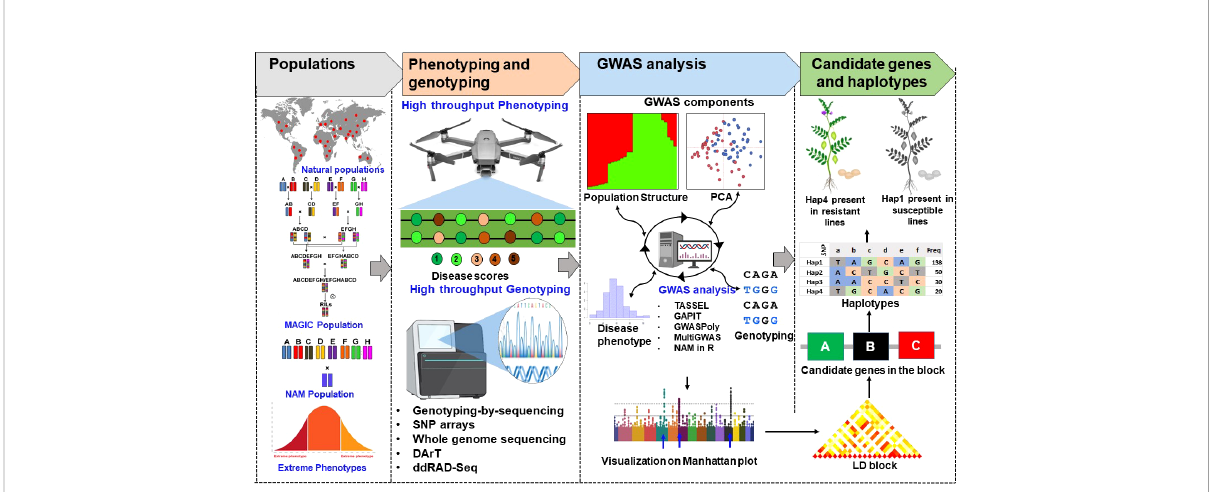
FIGURE 3 Illustration of genome-wide associations studies to identify genes associated with disease resistance. The partially structured (NAM and MAGIC) and unstructured populations (germplasm lines, association panels) can be used for high throughput phenotyping and genotyping to perform high resolution association mapping with advance tools for genome wide association analysis (GWAS). The peaks identi fi ed in GWAS analysis can be used for identi fi cation of LD blocks. Each LD block includes one or few candidate genes associated with the trait can be used for validation or development of diagnostic markers for genomics associated breeding. The validated genes can be further used for identi fi cation of haplotypes for disease resistance or disease